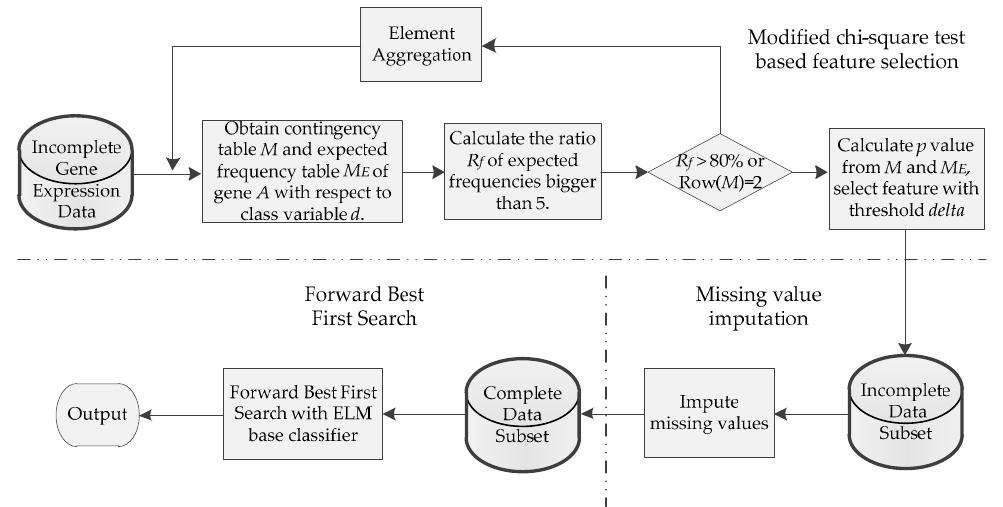
Figure 6. Flowchart of the proposed method. The dotted line divide the framework into three main steps.